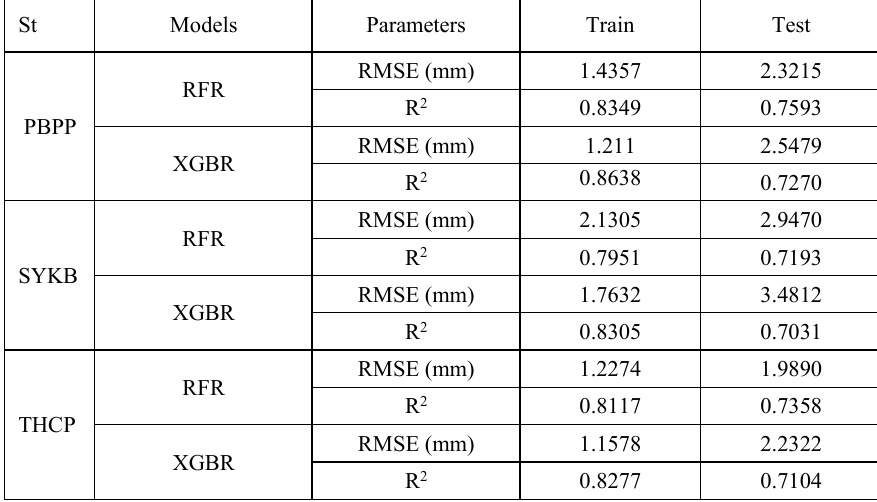
Table 1. Statistics of PWV estimates for different models and